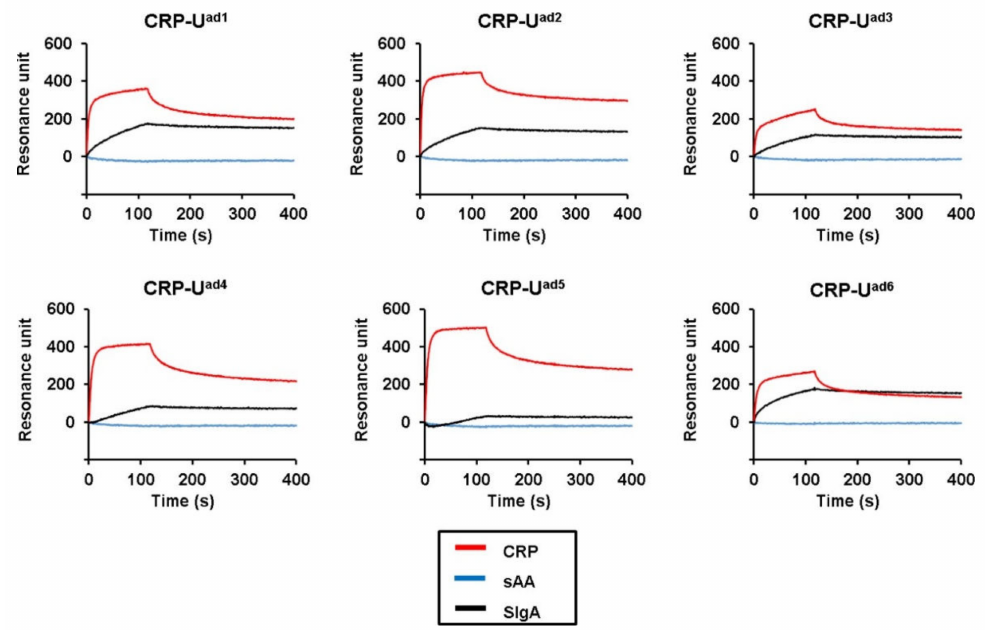
Figure A1. SPR response curve of the interaction between either CRP, salivary protein secretory immunoglobulin A (SIgA), or salivary α -amylase (sAA)) and the candidate aptamers CRP–U ad1 , U ad2 , U ad3 , U ad4 , U ad5 , and U ad6 . CRP, SIgA, or sAA (400 nM each) were injected over the respective aptamer-immobilizing sensor chips for 120 s at a flow rate of 50 µ L / min. The red line represents the CRP measured curve, while the blue and black lines represent the sAA and SIgA recorded curves, respectively.